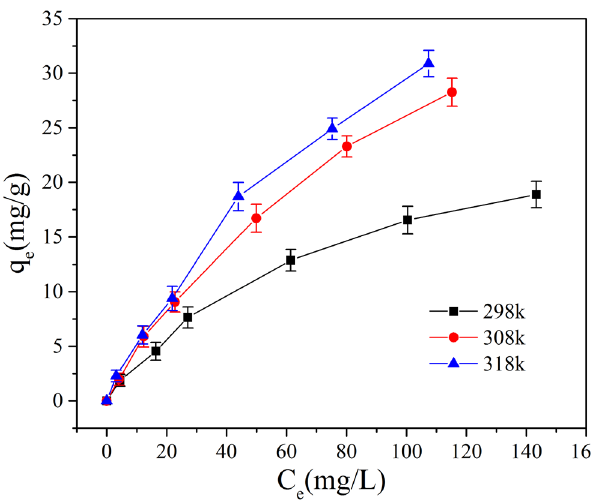
Figure 13. Effects of temperature on removal of Mn(II) by